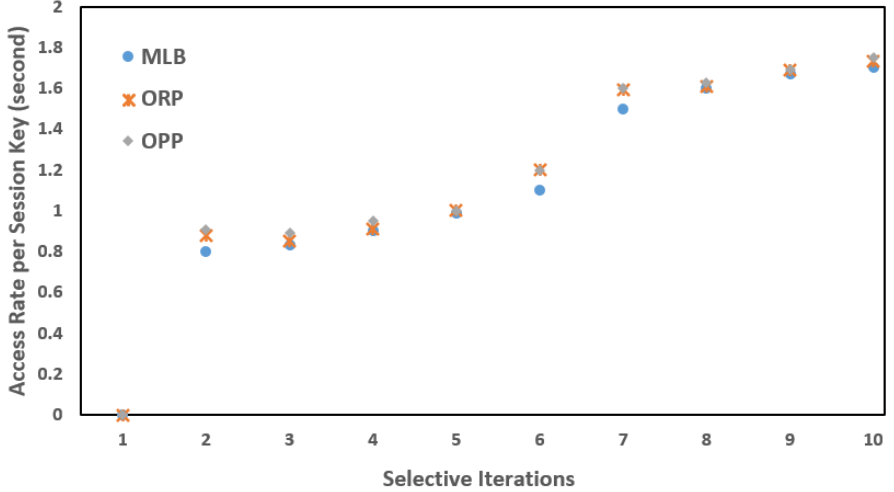
Figure 9. AV access rates per session key via the cloud: session key = 2 s; time periods: 10, 20, and 30 min.